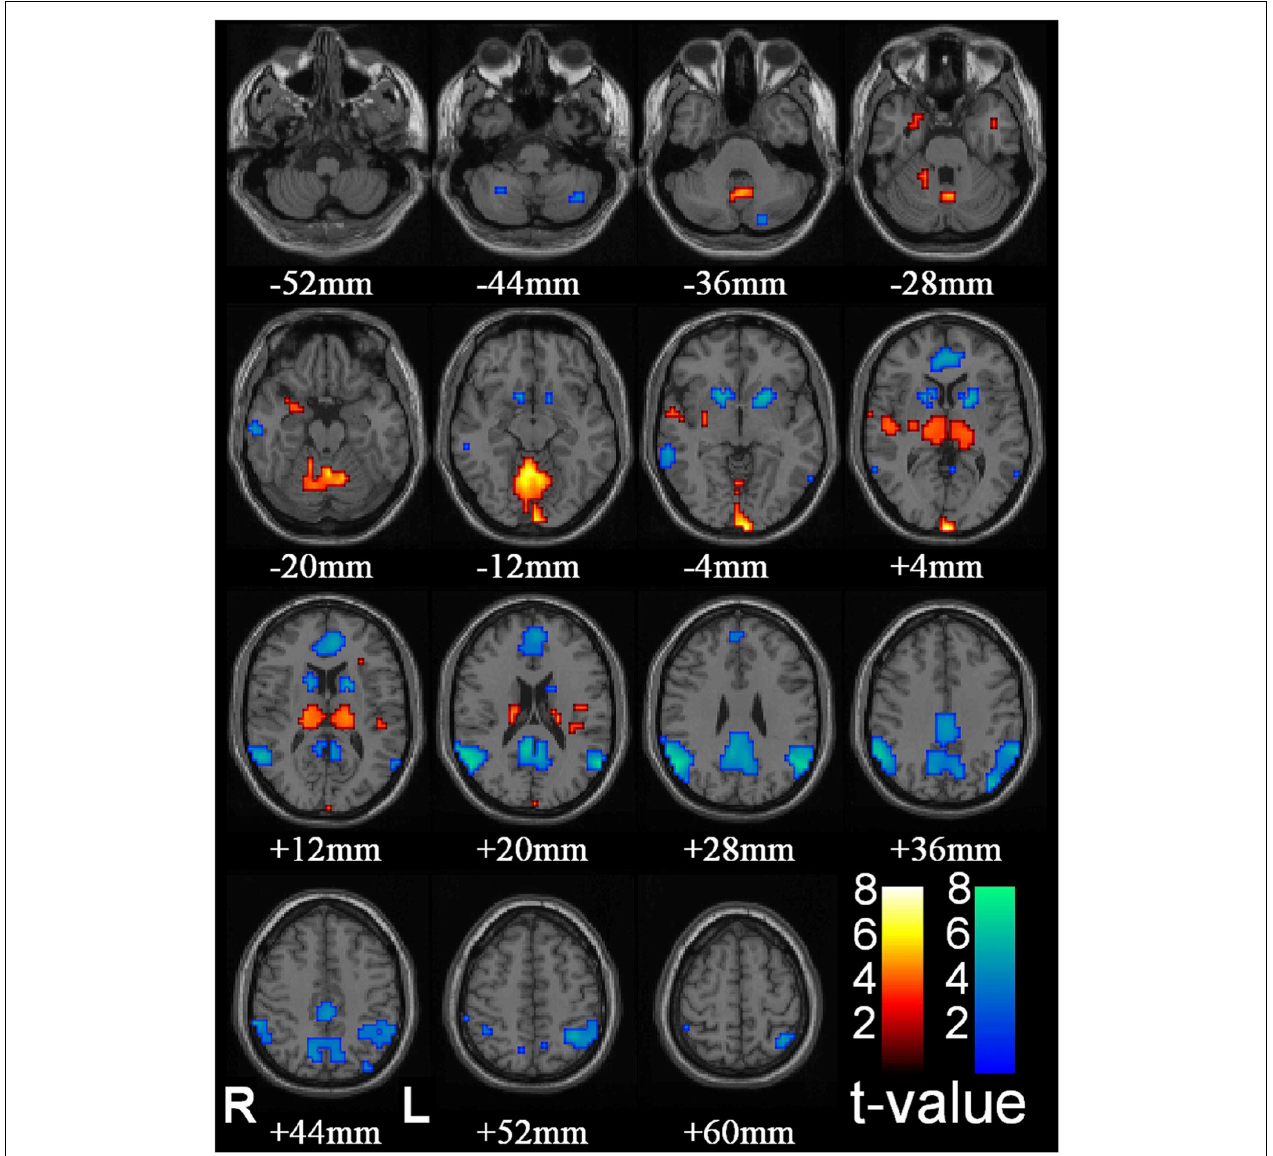
patients during CPT or RTT; 14 in 4 patients duringVFT, 3 patients with both CPT/RTT andVFT runs) were analyzed using GLM with canonical HRF in SPM2.The dataset in this analysis was the same as Figure 1. fMRI increases were seen in bilateral thalamus, occipital (calcarine) cortex, and to a lesser extent in the midline cerebellum, anterior and lateral temporal lobes, insula, and adjacent to the lateral ventricles. fMRI decreases were seen in the bilateral lateral parietal, medial parietal, and cingulate cortex and basal ganglia (46) (published with permission from the Journal of Neuroscience, copyright 2010,